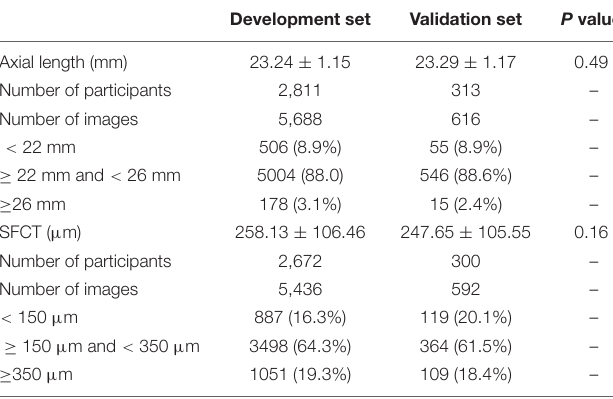
TABLE 1 | Baseline characteristics (mean ± standard deviation) of participants in the development group and validation